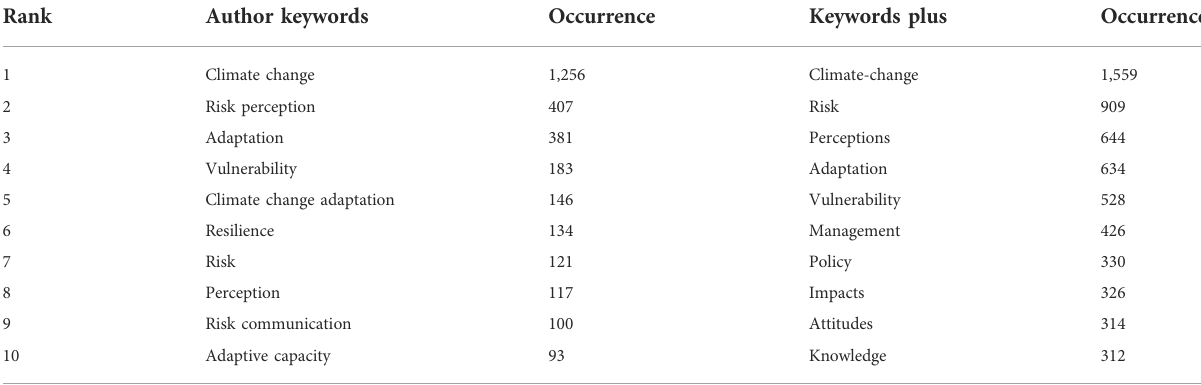
TABLE 4 The Top 10 frequencies of author keywords and keywords used during 2000 –